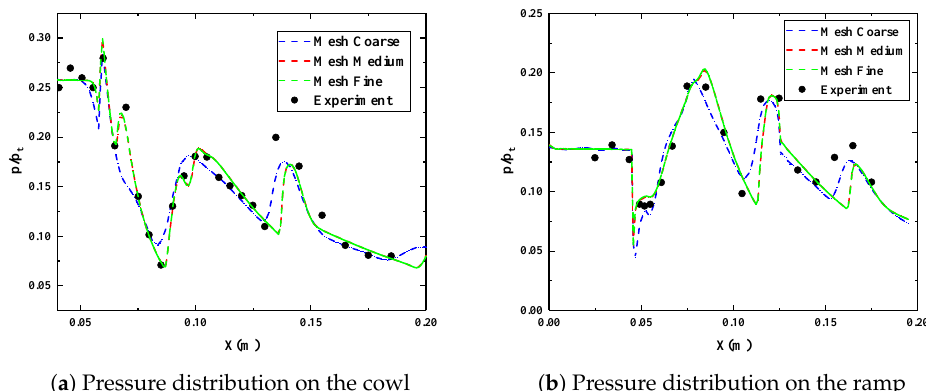
Figure 7. Comparison of RANS results for three different sparseness meshes.